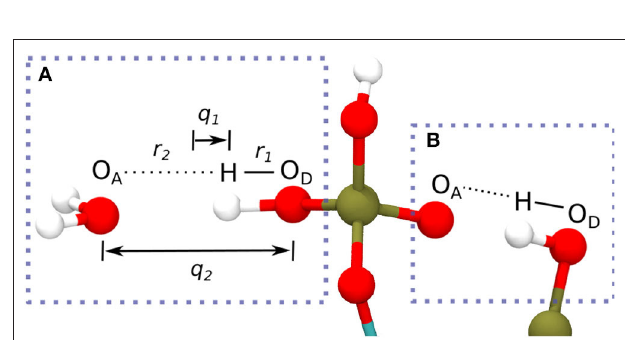
FIGURE 2 | Definition of coordinates q 1 and q 2 in a HB between water’s oxygen (O A ) and IHP’s oxygen (O D ) from a phosphate group (A) ( Limbach et al., 2009 ), intramolecular HB in IHP (B)